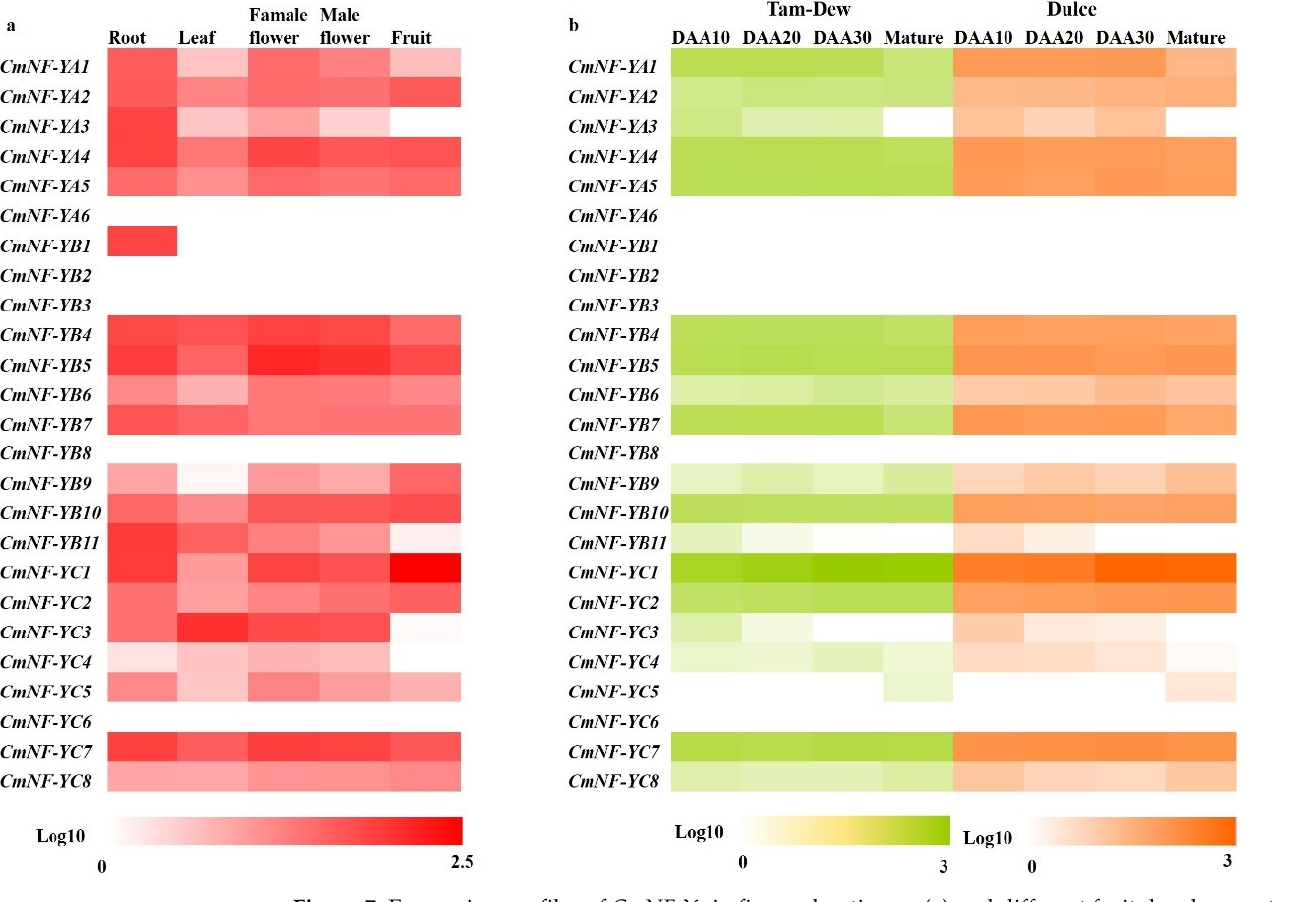
Figure 7. Expression profiles of CmNF-Ys in five melon tissues ( a ) and different fruit development stages ( b ) based on the transcriptome data. The RPKM values were transformed to log10. The expression in various melon tissues was shown, including root, leaf, female flower, male flower, and fruit. Tam-Dew is a green flesh, non-climacteric line. Dulce is an orange flesh, climacteric line. DAA: days after anthesis.